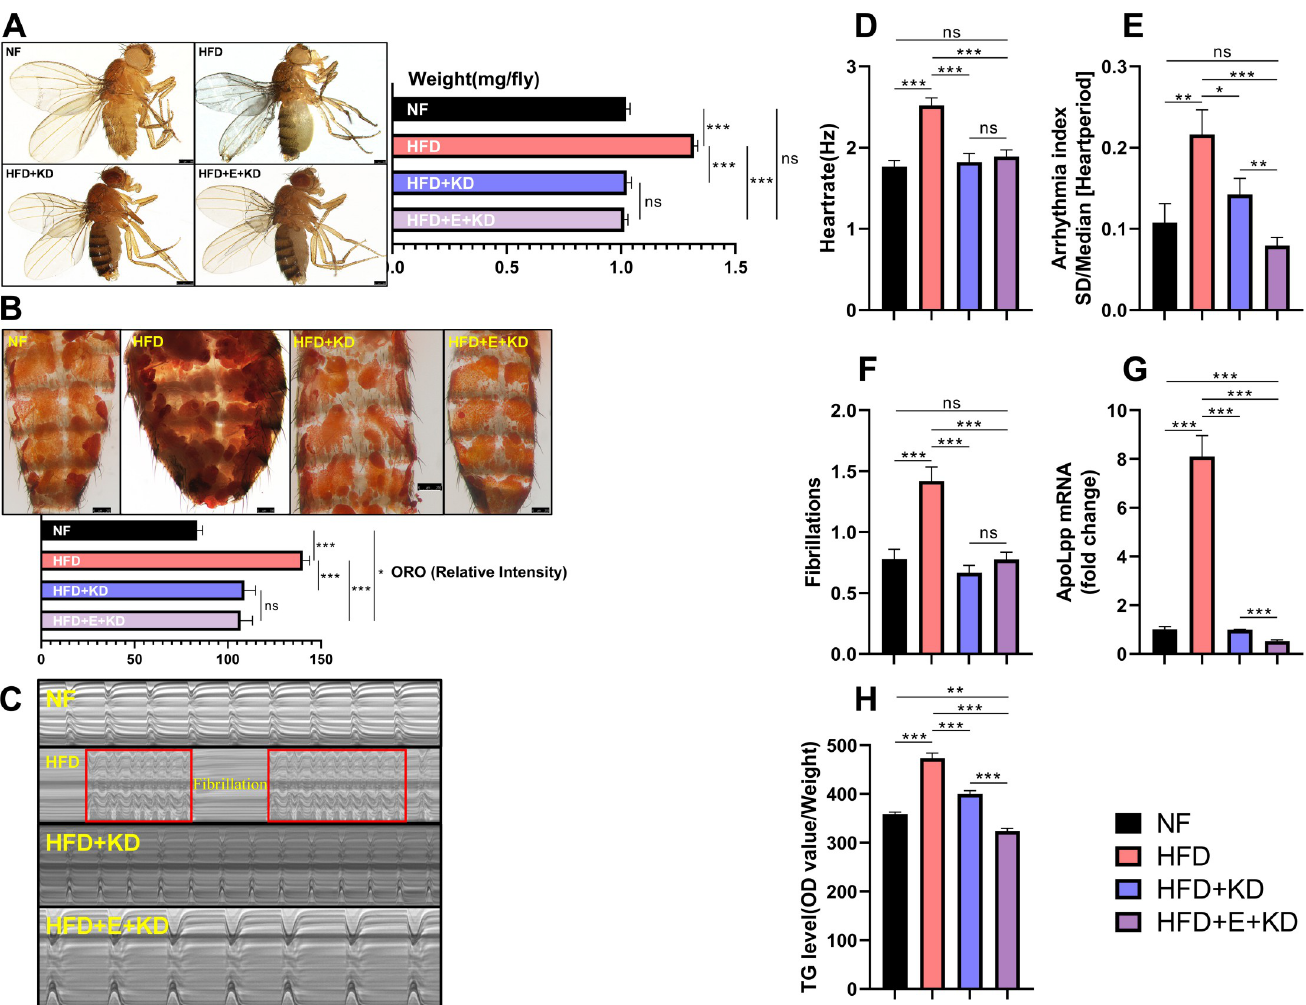
Fig 4. Combined effect of regular exercise and apoLpp knockdown in cardiomyocytes. (A) Photographs and body weights of 10-day-old flies. The body weight was obtained using an electronic microbalance, N = 15. The body weight of flies in the HFD group was significantly higher than the other three groups. (B) ORO staining of the abdomen of flies. Quantification of ORO intensity, N = 5. The intensity of ORO staining of flies in the HFD group was significantly higher than that of the other three groups. (C) Drosophila M-mode cardiogram and the interception length was 10 s (This refers to the length of the electrocardiogram of 0–10 s). (D-F) M-Mode analysis. Quantification of fly heart rate, arrhythmia index and fibrillation, N = 30. The heart rate, arrhythmia index and fibrillation of the three groups of NF, HFD+KD and HFD+E+KD were significantly lower than those of the HFD group. Compared with the HFD+KD group, the HFD+E+KD group had no significant difference in heart rate and fibrillation, but the arrhythmia index was significantly lower. (G) The relative expression level of apoLpp in cardiomyocytes of flies. The expression level of apoLpp mRNA in cardiomyocytes of HFD group was significantly higher than that of the other three groups. In addition, compared with HFD+KD, the expression of apoLpp mRNA in cardiomyocytes of HFD+E+KD group was significantly reduced. The samples included at least 60 isolated hearts. (H) Whole-body TG levels in flies. The whole-body TG level in the HFD group was significantly higher than the other three groups. In addition, compared with the NF and HFD+KD groups, the HFD+E+KD group’s whole-body TG levels were significantly lower. N = 5, repeated three times.